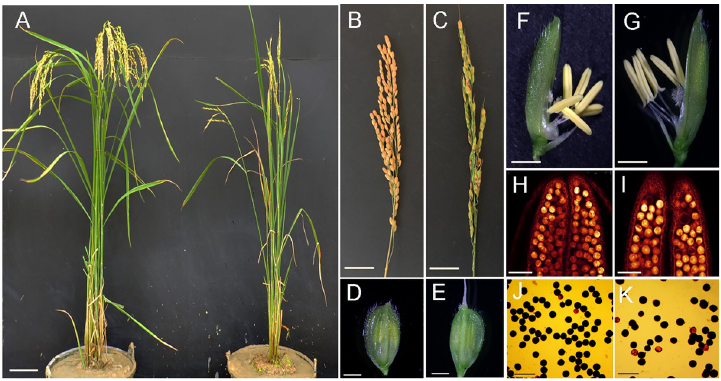
Fig 1. Phenotypic characterization of Taichung65-4x and its corresponding diploid rice. (A) Morphologies of Taichung65-4x and Taichung65-2x. Bars = 10 cm. (B) and (C) Panicles of Taichung65-4x and Taichung65-2x. Bars = 2 cm. (D) and (E) Grain size of Taichung65-4x and Taichung65-2x. Bars = 1 mm. (F) and (G) Floral organs of Taichung65-4x and Taichung65-2x. Bars = 1 mm. (H) and (I) Anthers of Taichung65-4x and Taichung65-2x were observed by using the WE-CLSM (Whole-mount eosin B-staining confocal laser scanning microscopy). Bars = 100 μ m. (J) and (K) Pollens of Taichung65-4x and Taichung65-2x, respectively. Bars = 100 μ m.